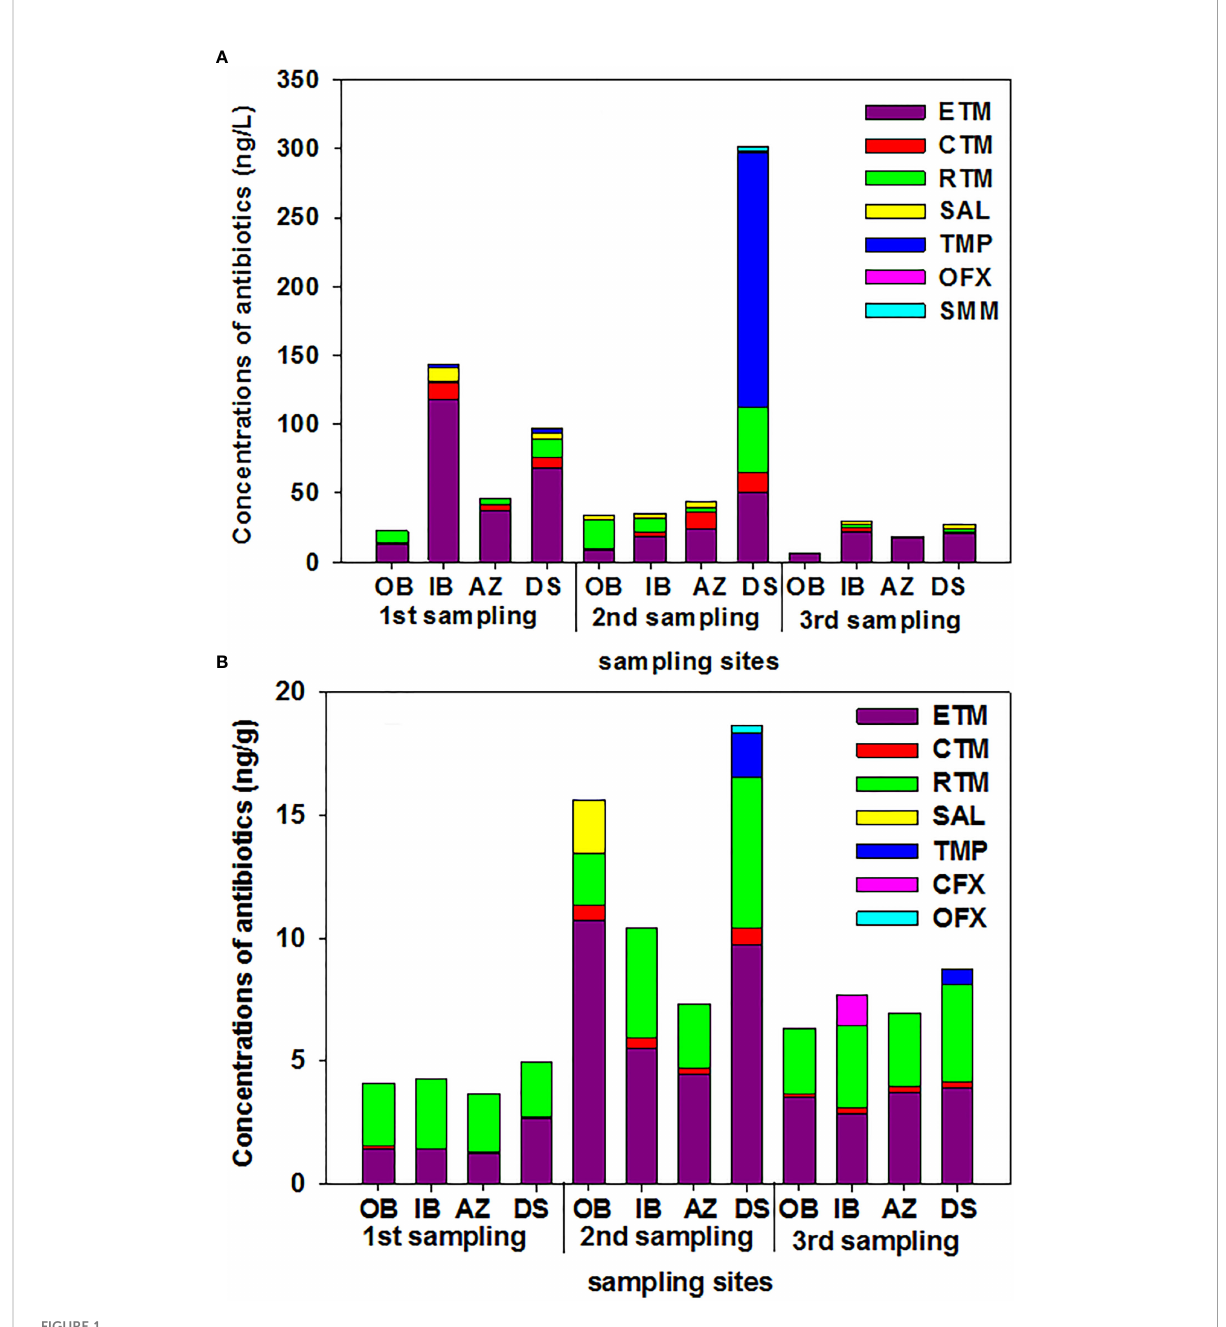
FIGURE 1 Concentrations of antibiotics in water and sediment samples for three sampling events in Dapeng Cove, Shenzhen, South China. OB, the open bay; IB, the inner bay; AZ, the aquaculture zone; DS, domestic sewage. (A) water samples. (B) sediment